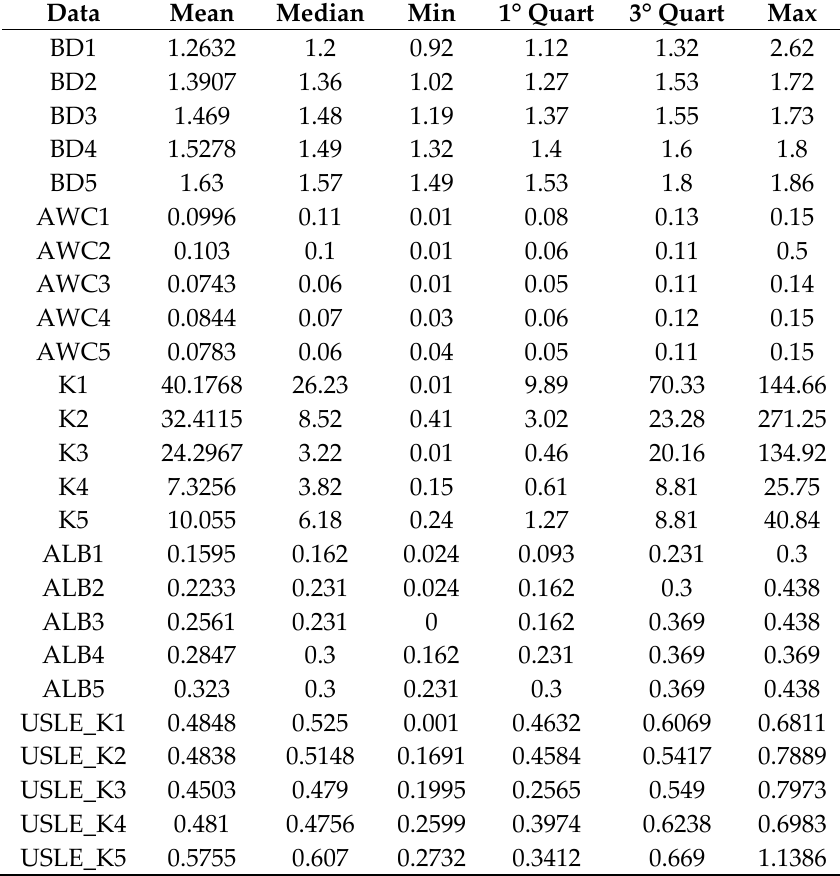
Table 1. Summary of the statistics of the parameters calculated by